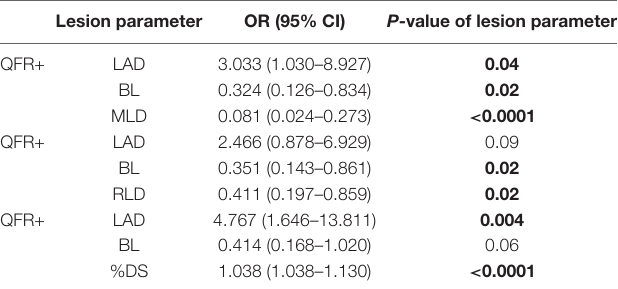
TABLE 7 | Logistic regression model with three lesion parameters added to